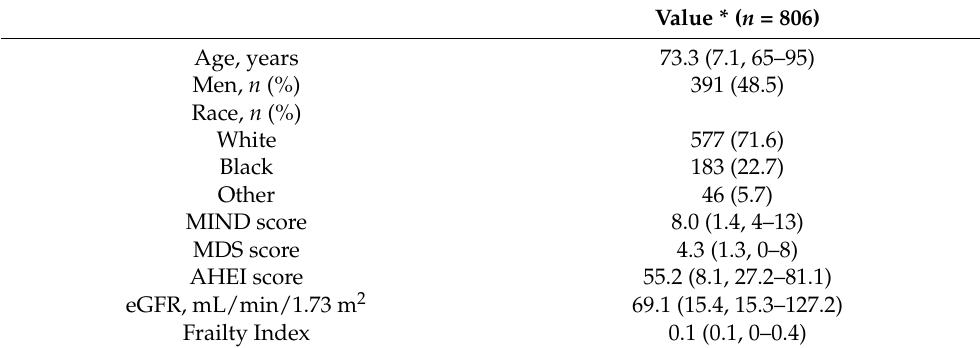
Table 1. Socio-demographic characteristics, dietary scores, and frailty index